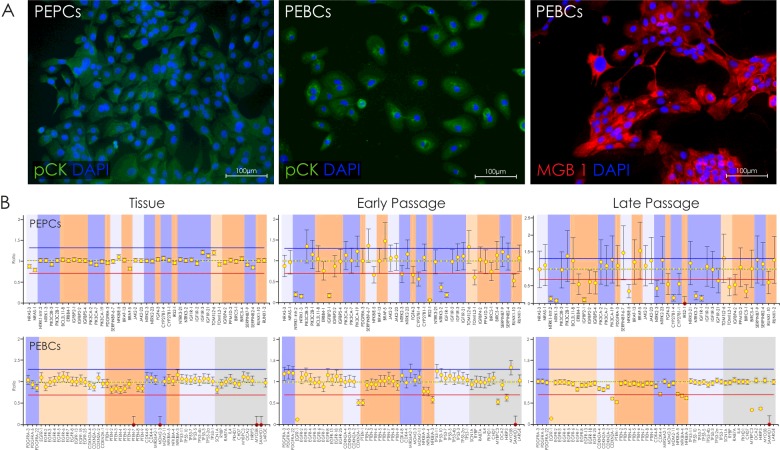
Genetic and phenotypic characteristics of PEPCs and PEBCs(A) PEBCs and PEPCs immunostained for characteristic protein markers–cytokeratins (pCK) and mammaglobin A (MBG1). (B) MLPA analysis showing tumour-characteristic changes in gene copy number.